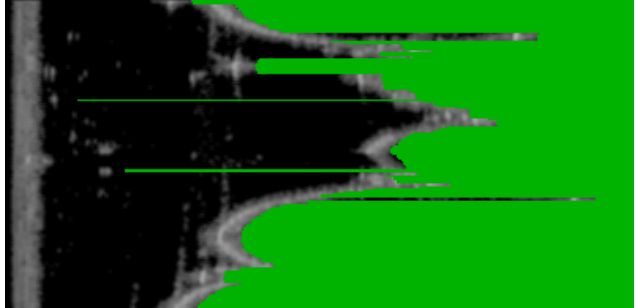
Figure 15. Illustration of the feature rejection region (in green) employed in image 9 of dataset